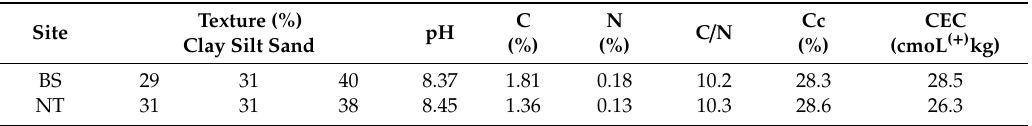
Table 1. Soil physicochemical properties of the studied sites (C: organic carbon; Cc: carbonate content; CEC: cation-exchange